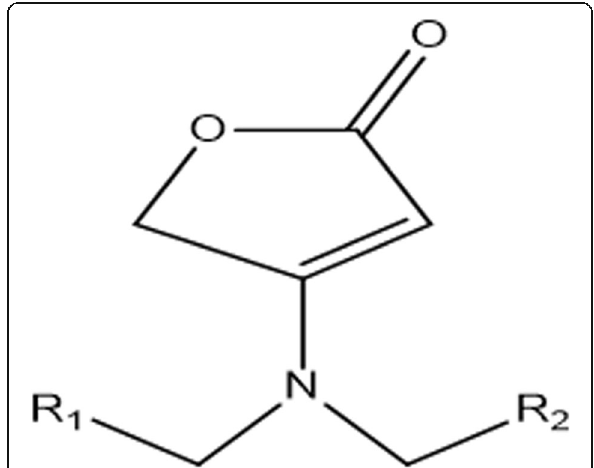
Fig. 1 The parent compound of the dataset